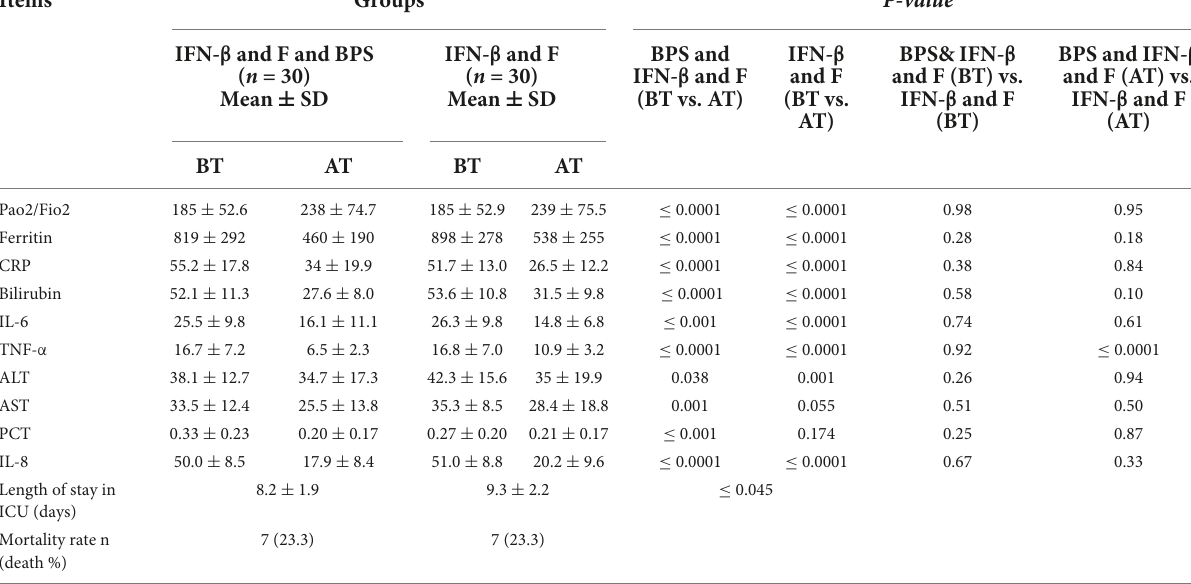
TABLE 2 Comparison outcome parameters between two participant groups. Items Groups P-value IFN- β and F and BPS ( n = 30) and F